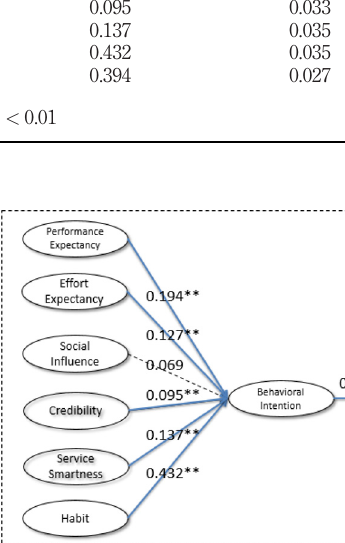
Figure 2. PLS-SEM